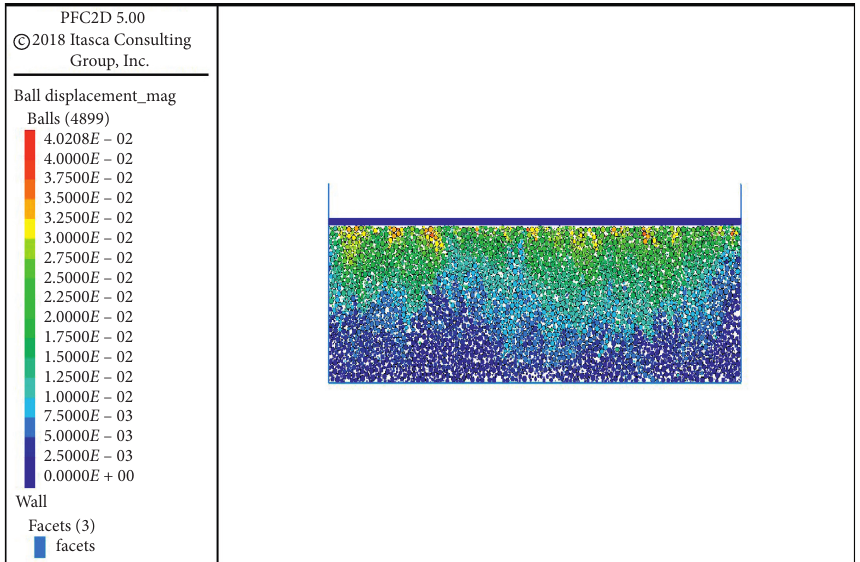
Figure 16: Discrete element particle migration map of 50cm thick reclaimed soil with three compactions.